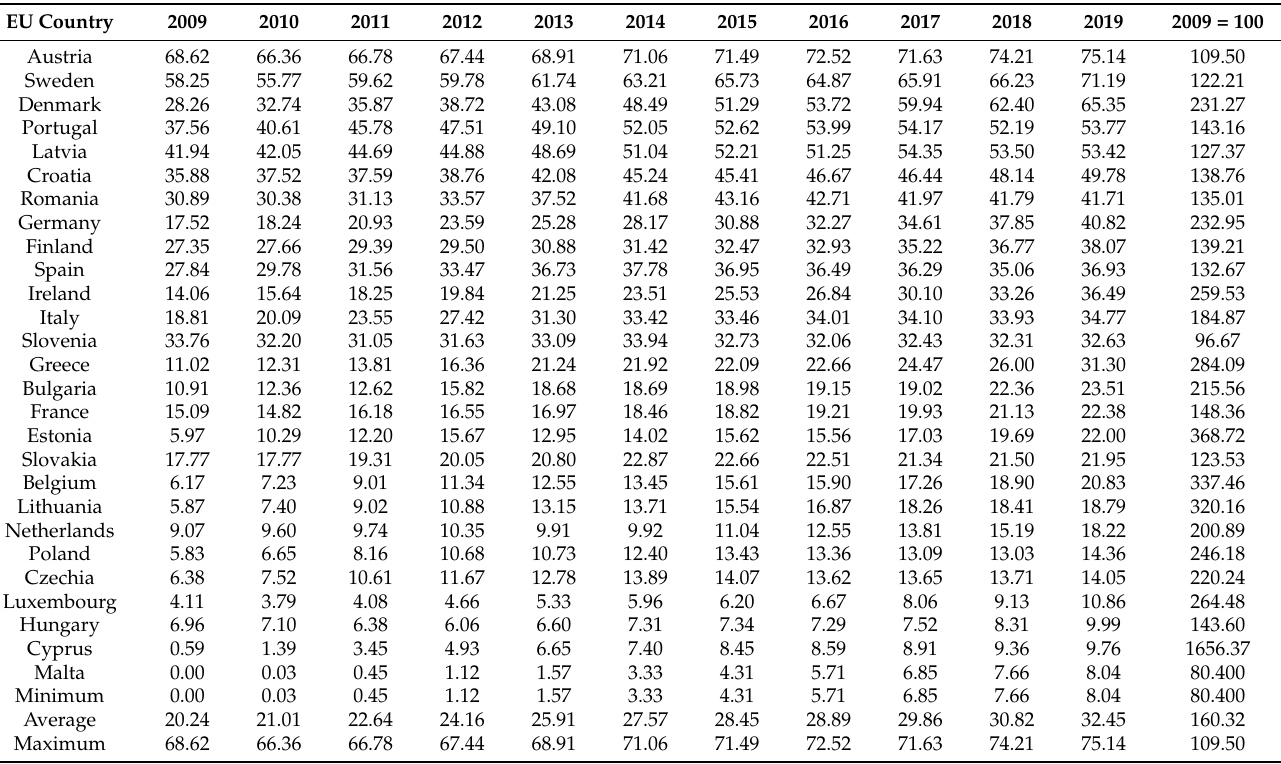
Table 2. Share of renewable energy in electricity in years 2009–2019 (Note: countries were ordered by 2019 index value, from highest to